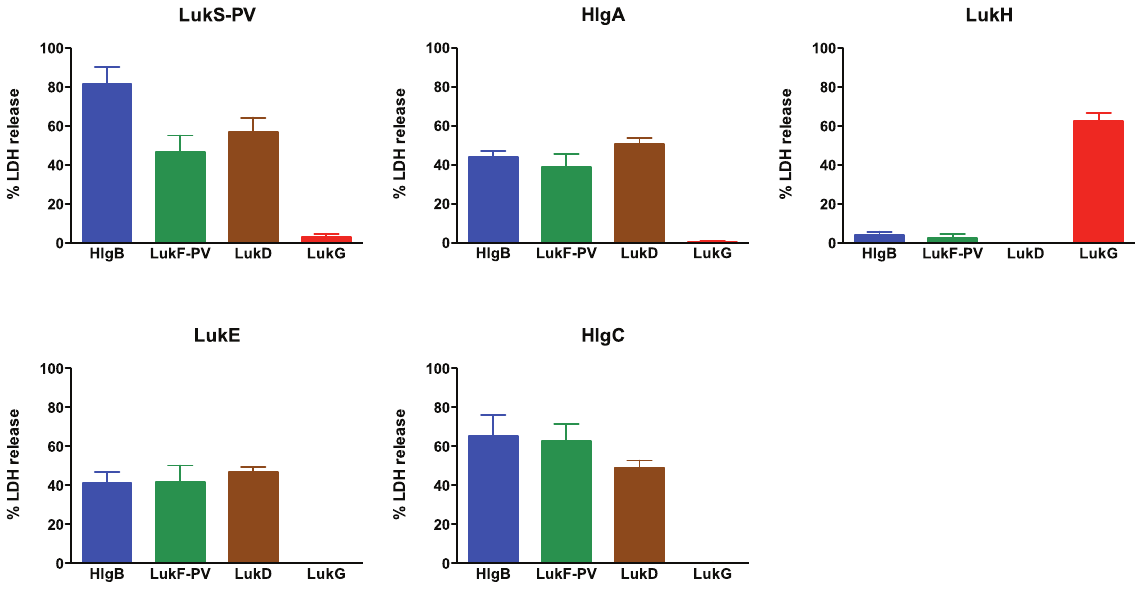
Figure 6. Cytolytic activity of combinations of S and F components from LukGH, PVL, LukDE, and c -hemolysin. LDH release was determined as described in Figure 4. Each panel shows a particular S component (header) as mixed with various F components (LukG: red, LukF-PV: green, LukD: brown, HlgB: blue). The concentration of all proteins was 500 nM. The results shown are the mean of three independent experiments 6 SEM.